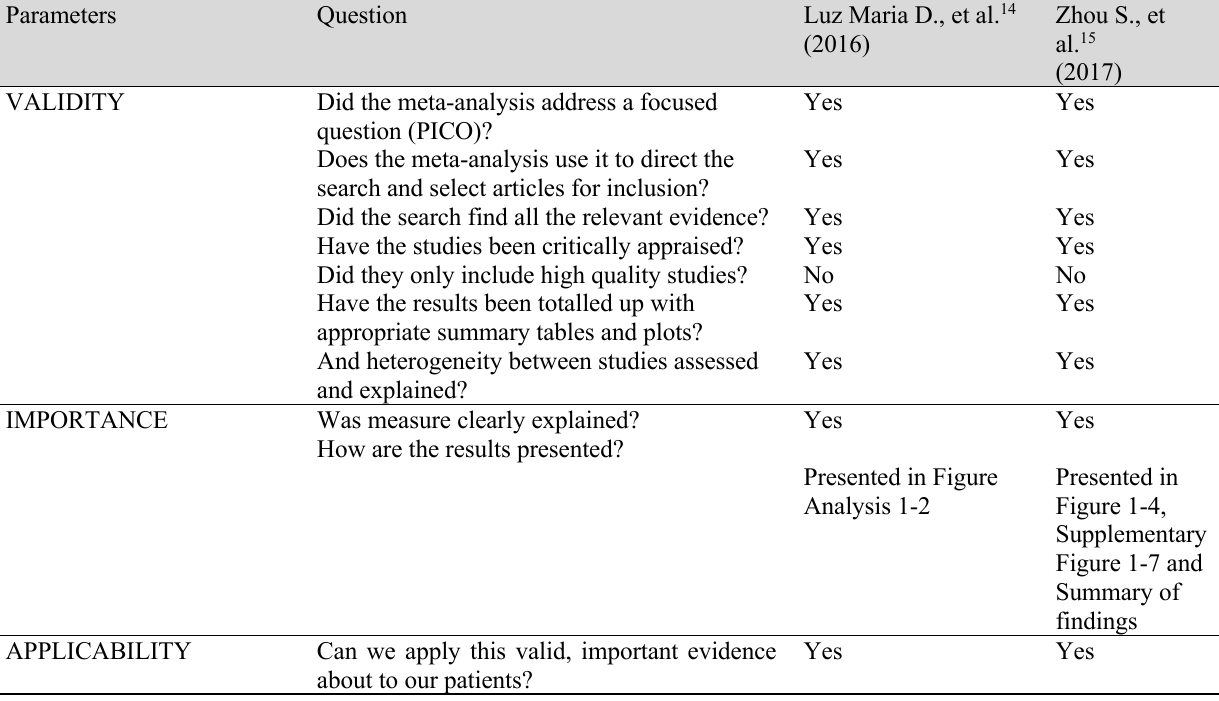
Table 4. Critical appraisal of systematic review and meta-analysis